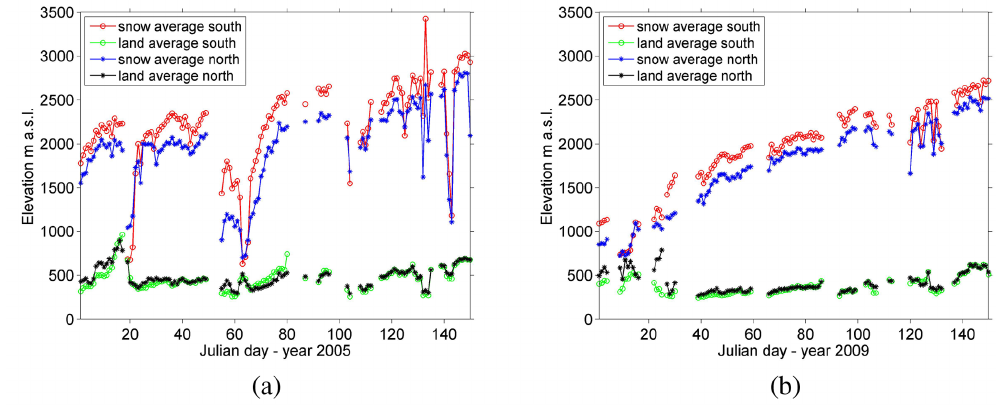
Figure 9. Regional snow and land lines from January to May computed per aspect classes (north: aspect > 315 ◦ and aspect < 45 ◦ ; south: 135 ◦ < aspect < 225 ◦ ). Year 2005 (a) and 2009 (b) . Values are provided only when output maps by step 2 are less than 50% cloud covered.